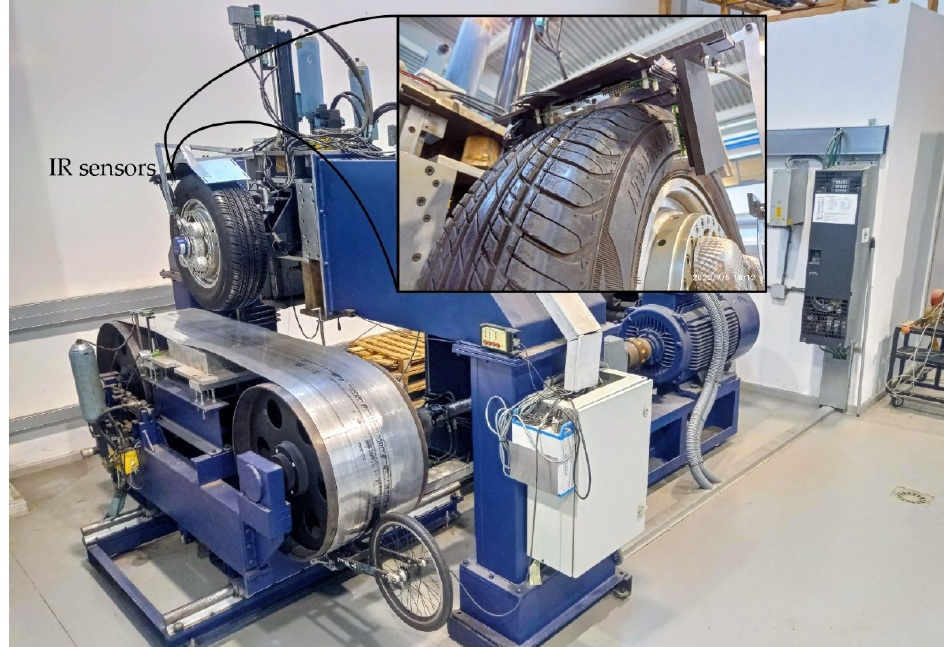
Figure 2. Tire testing machine property of the research group.